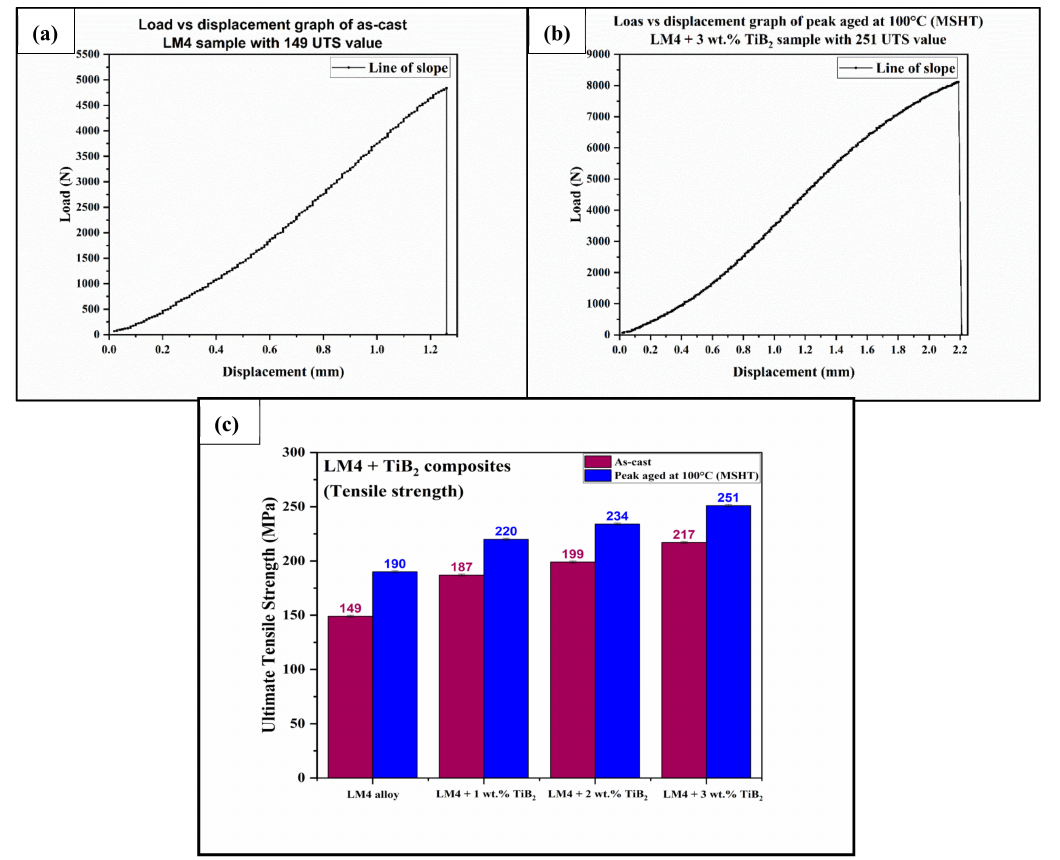
Figure 15. ( a , b ) Tensile curves of the as-cast LM4 and peak-aged LM4 + 3 wt.% TiB 2 composite. ( c ) Comparison of UTS values of the as-cast and peak-aged